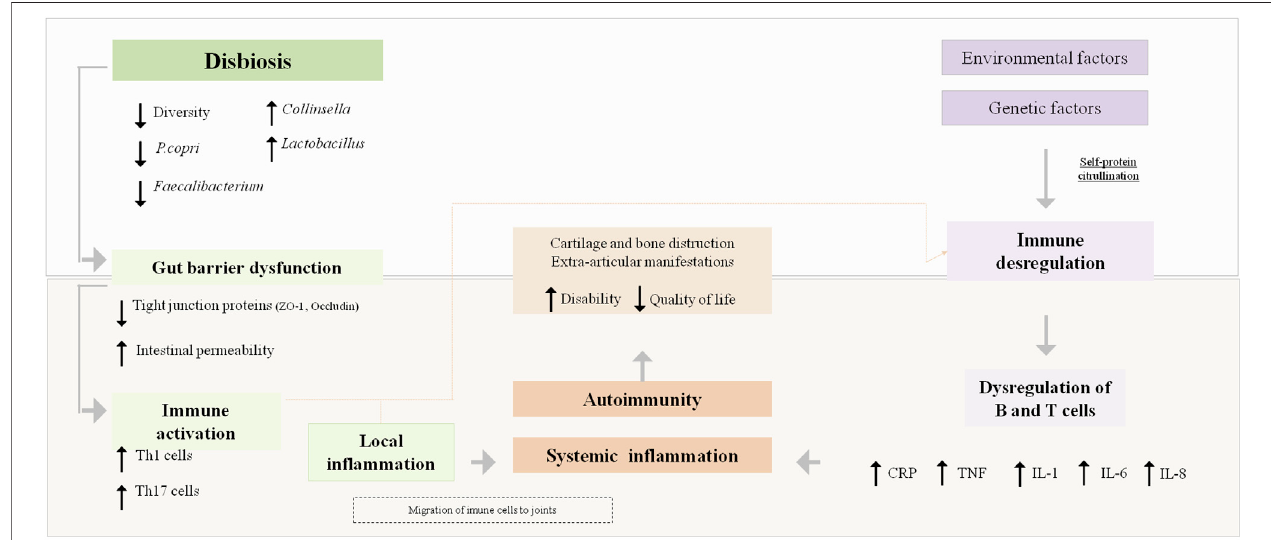
FIGURE 1 | Rheumatoid arthritis pathophysiology and the proposed mechanisms by which gut microbiota could in fl uence its pathogenesis. CRP, C-reactive; P. Copri, Prevotella copri; ZO-1, Zonula occluclens-1; IL, Interleukin; TNF, tumour necrosis factor.